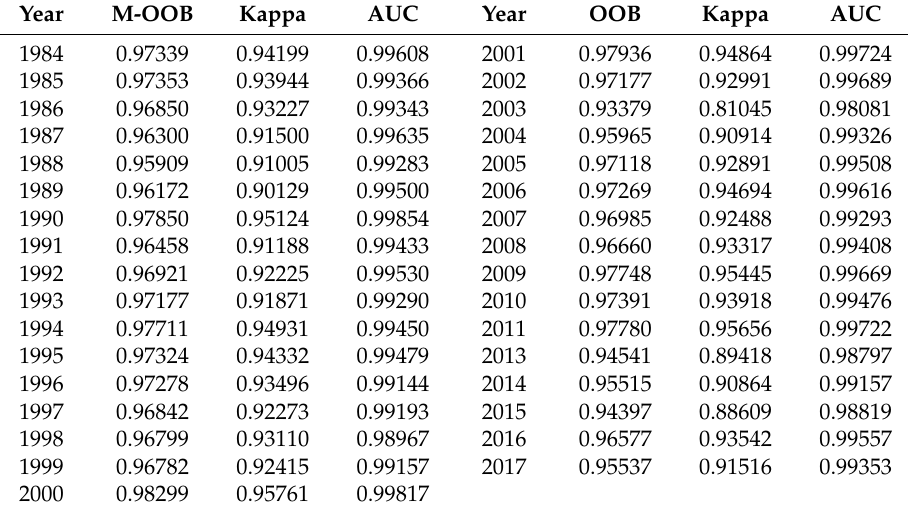
Table 2. Accuracy of the classification results on the ground truth